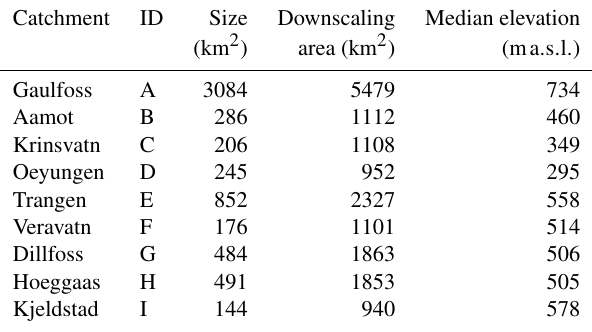
Table 1. Characteristics of the nine catchments in Trøndelag, Nor- way, considered in the stochastic simulations of gridded daily pre- cipitation.